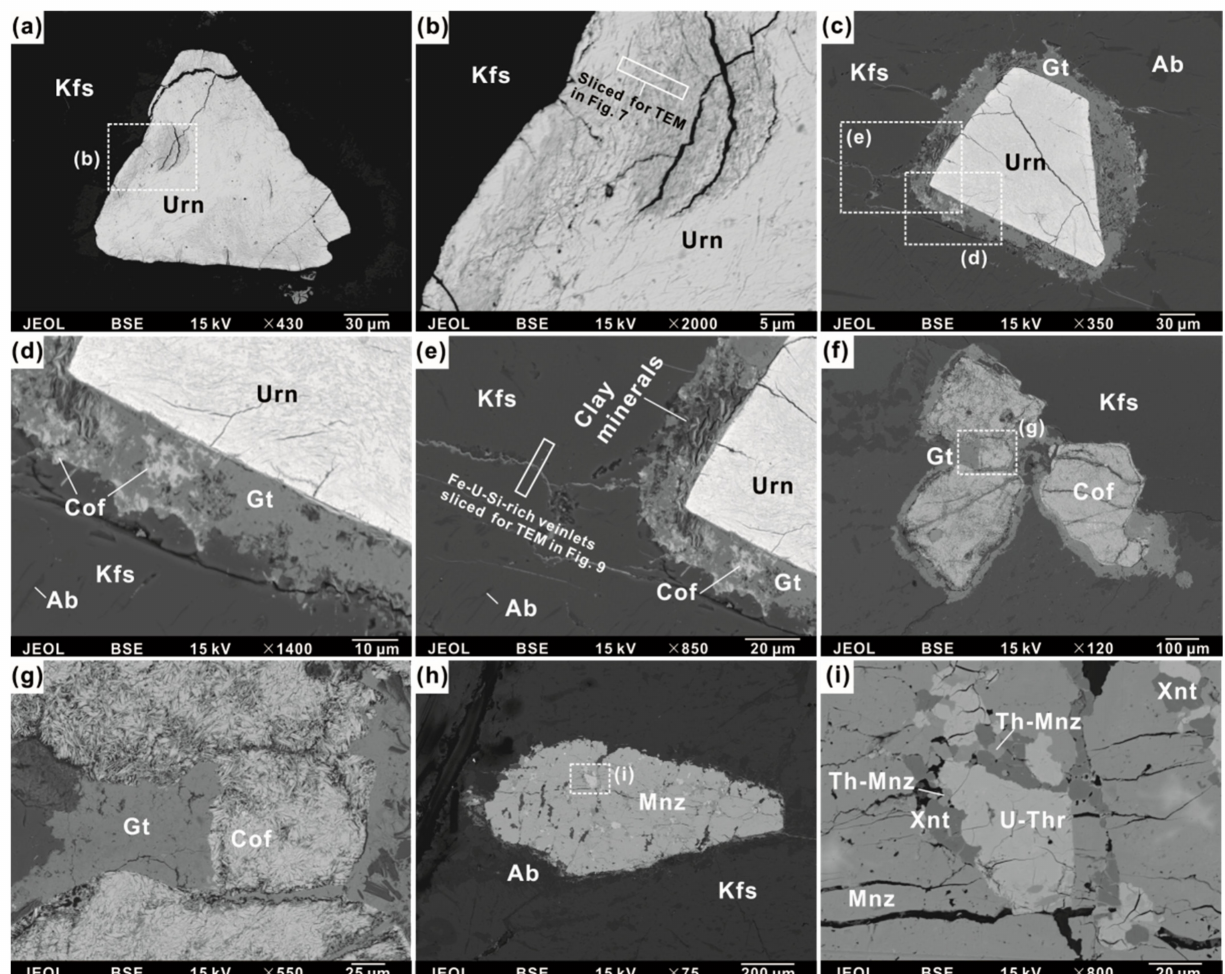
Figure 6. Backscattered electron images of altered uraninite grains and associated minerals from the Guangshigou deposit. ( a , b ) Dark, altered zone along fractures in uraninite. ( c ) Radiohalo around altered uraninite included in K-feldspar, and K-feldspar is partially replaced by albite. ( d , e ) Details of ( c ) showing the radiohalo around uraninite mainly composed of goethite, a Fe-aluminosilicate (probably clay minerals) and coffinite and Fe-U-Si-rich veinlets extending outwards from the altered uraninite. ( f , g ) Radiohalos mainly composed of goethite around altered uraninite showing a high degree of coffinitization. ( h , i ) Monazite is replaced by hydrothermal Th-rich monazite, xenotime and uranothorite.